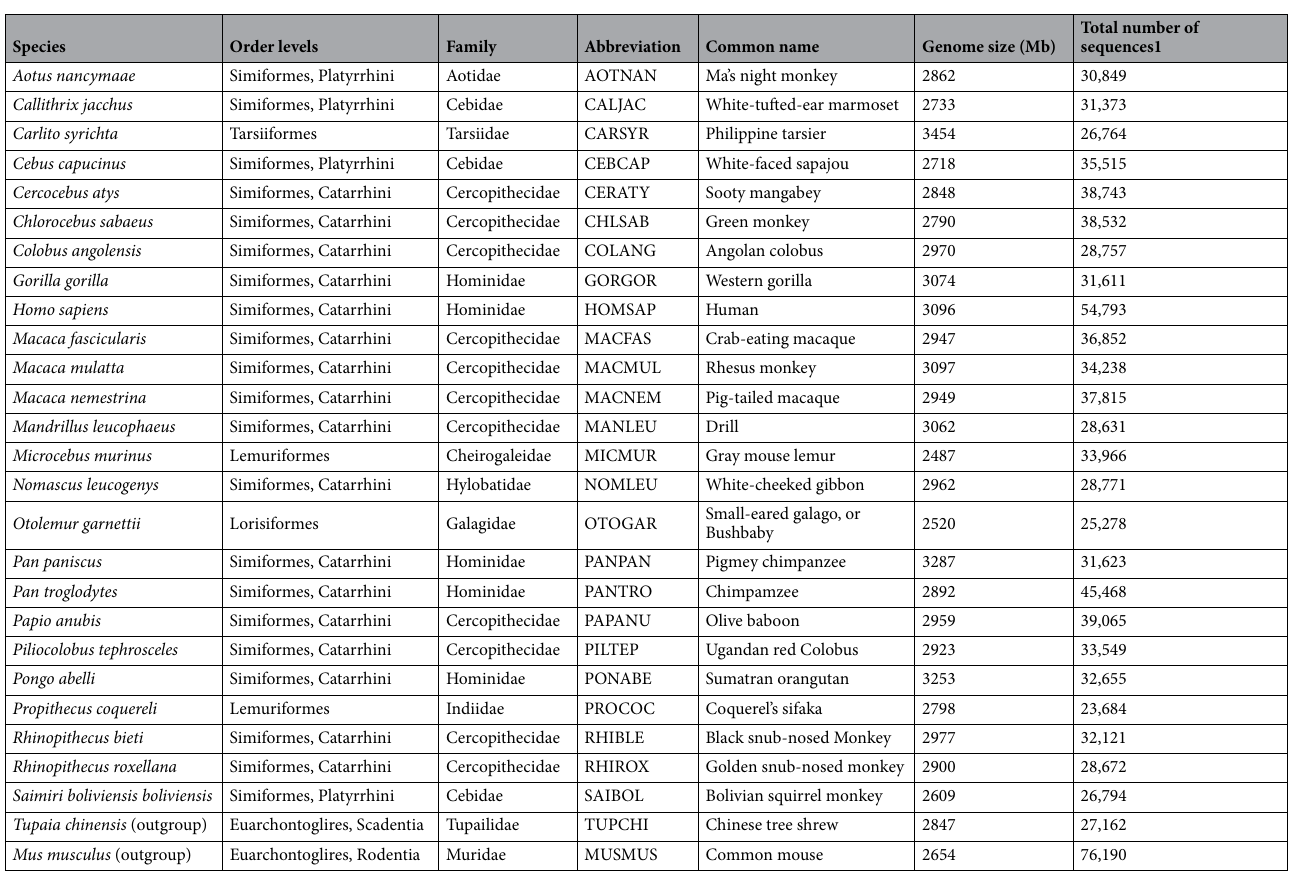
Table 3. Characteristics of genome-deduced proteomes (all from NCBI*) from mammals used in this work. * https ://www.ncbi.nlm.nih.gov/genom e ; protein sequences were retrieved from RefSeq database. 1. After clusterization at 99% and removal of sequences smaller than 50